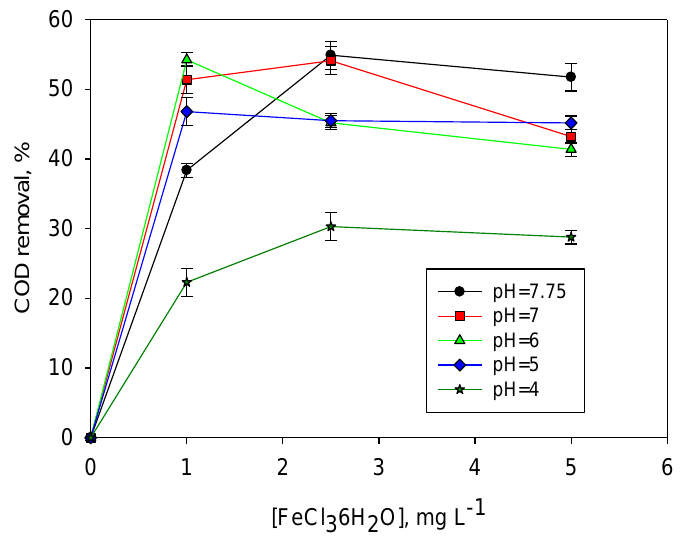
Figure 3. COD removal at different initial pH values for the conventional coagulation treatment (different coagulant dosages) of pre-electrocoagulated LL (pH = 4, 10 mA cm −2 , 3 cm electrode (different coagulant dosages) of pre-electrocoagulated LL (pH = 4, 10 mA cm − 2 , 3 cm electrode distance). distance).